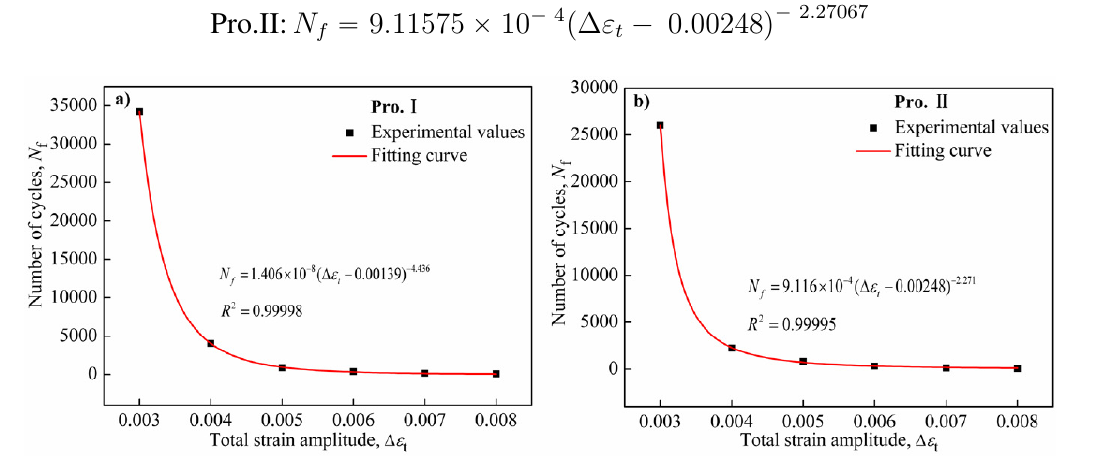
Figure 4. The reciprocal of cycles to failure versus the total strain ranges of the nickel-base alloy. ( a ) Pro.I; ( b ) Pro.II.